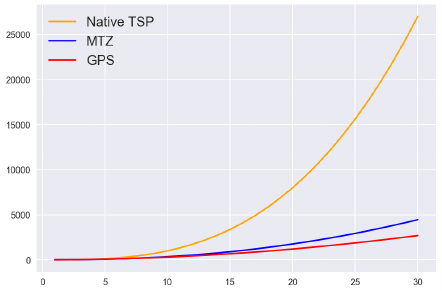
Figure 9. Comparison of the different models based on the number of qubits. This graph shows the behaviour and evolution of the numbers of qubits for each model. We see the best performance of our GPS model compared to the other